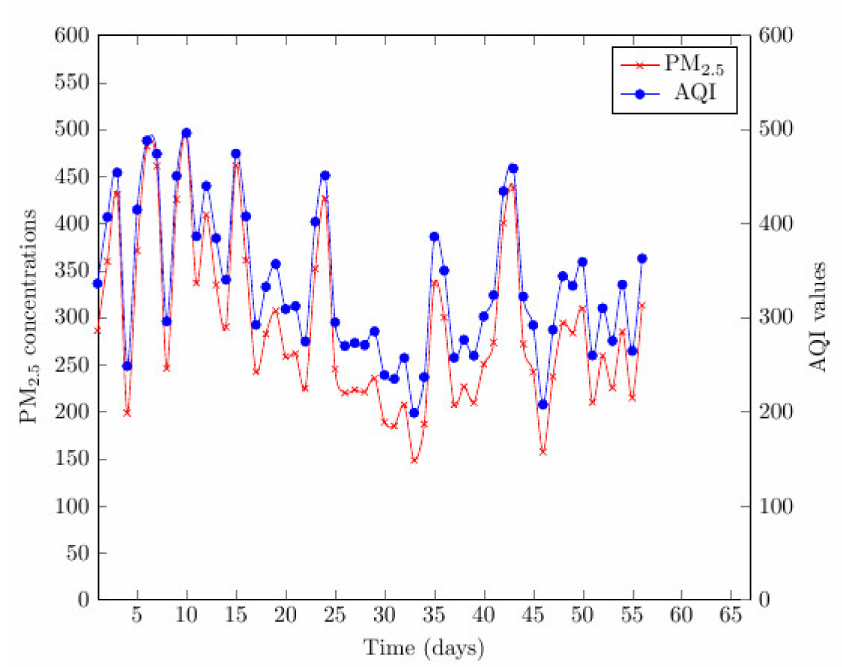
Figure 7. Evolution of PM 2.5 concentration and AQI values with